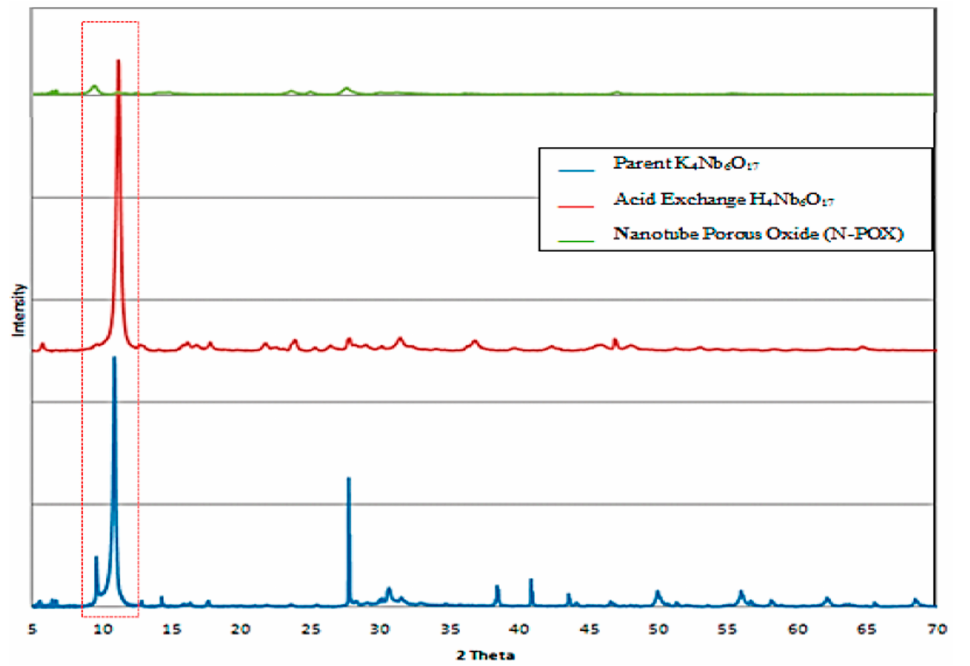
Figure 3. XRD patterns of parent material K 4 Nb 6 O 17 , acid exchanged H 4 Nb 6 O 17 , and nanotube porous oxide (N-POX), One can observed the disappearance of crystallinity particularly at 2θ = 10° (red dashed box).